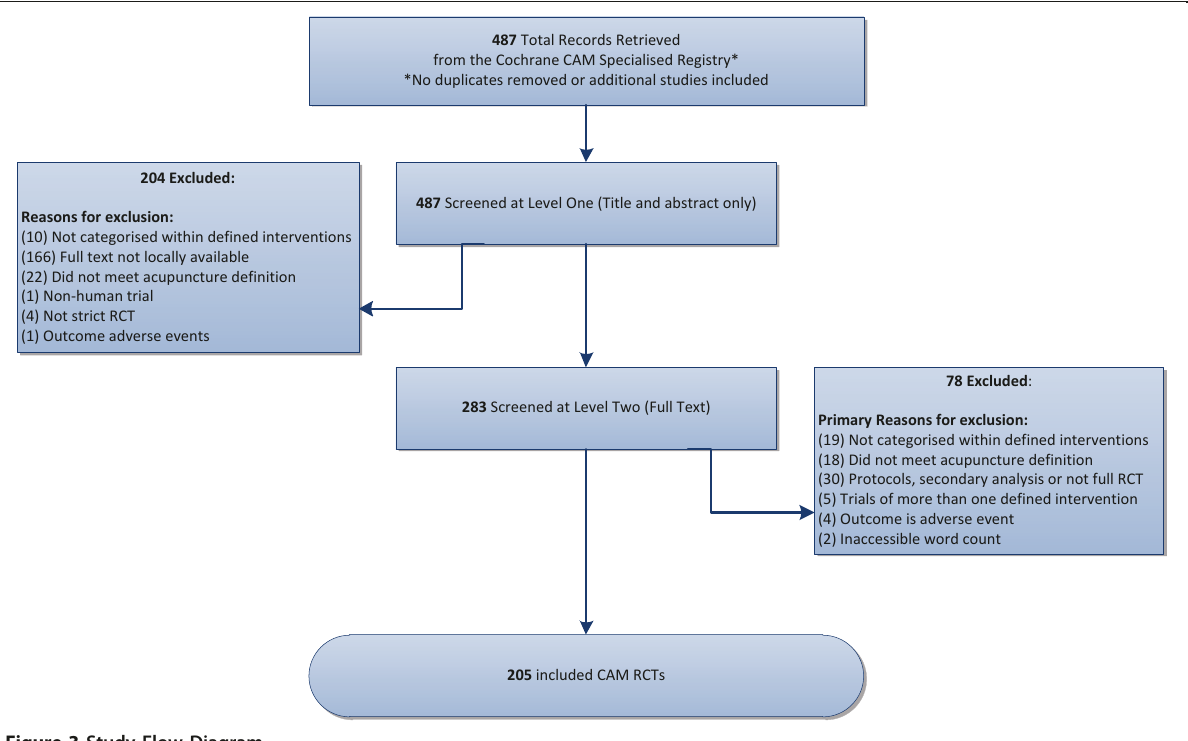
Figure 3 Study Flow Diagram